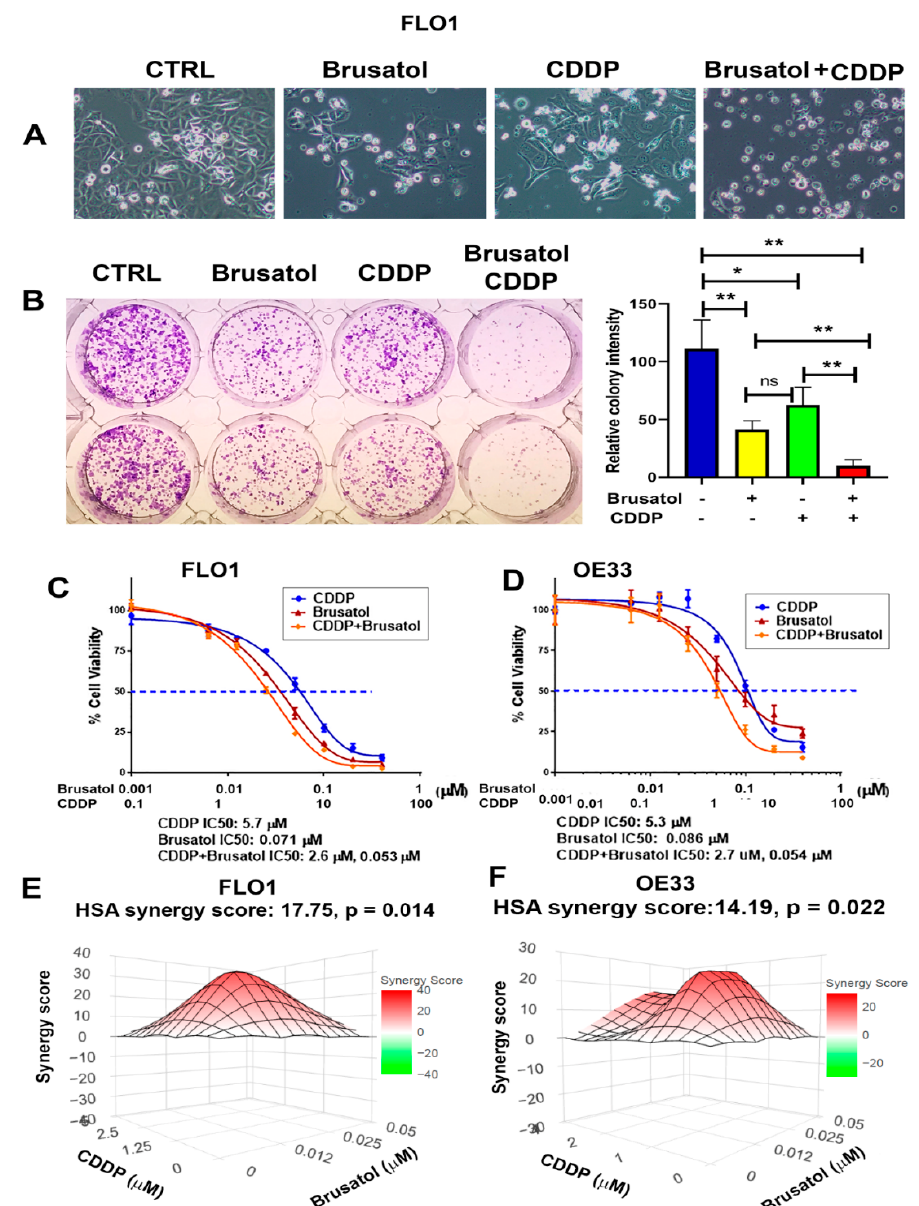
Figure 5. Brusatol synergized with cisplatin (CDDP) in killing EAC cells. ( A ) Bright images of cells treated with Brusatol, CDDP, or both for 3 days. ( B ) Clonogenic survival assay shows that combination treatment of Brusatol and CDDP killed a significantly more tumor cells. ( C , D ) The CellTiter Glo cell viability assay using Brusatol, CDDP, and both in FLO1 ( C ) and OE33 ( D ) cells. The IC50 of CDDP and Brusatol were plotted using Prism software. Data show that the combination treatment led to a significant 50% drop in CDDP IC50. ( E , F ) Synergy analysis using online synergyfinder tool (http://synergyfinder.org/, accessed on 10 May 2022) in FLO1 ( E ) and OE33 cells ( F ), demonstrating that a significant synergy effect occurred when applying Brusatol and CDDP. * p < 0.05; ** p < 0.01; ns, not significance.